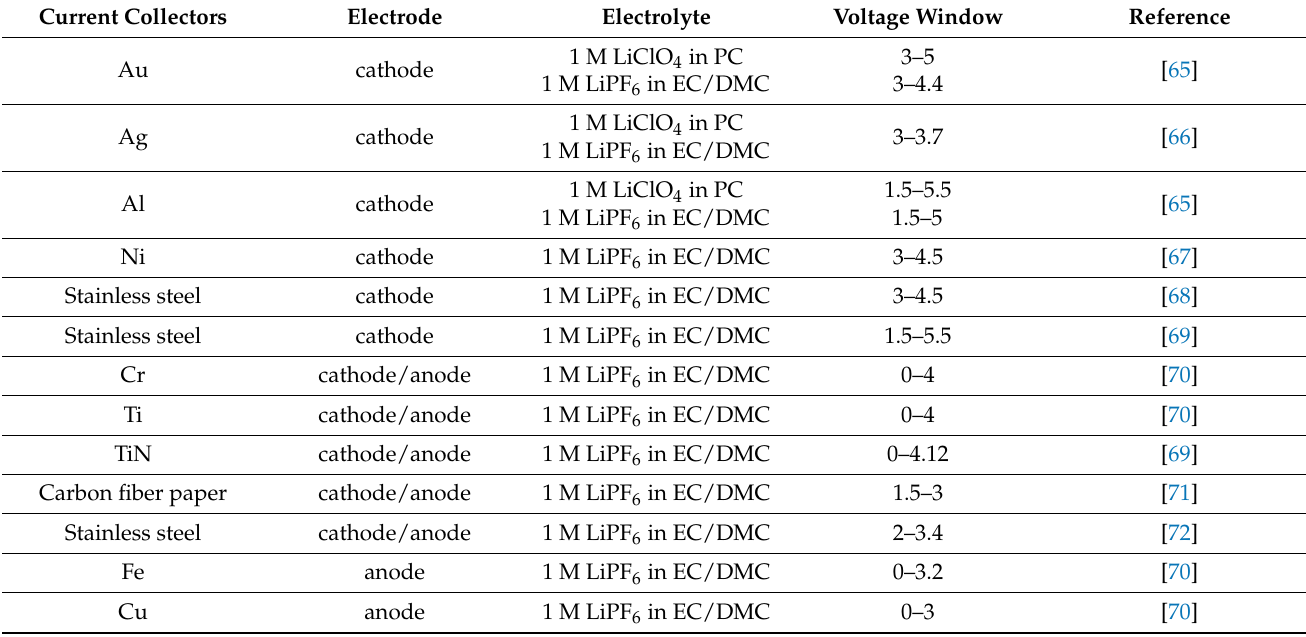
Table 1. Various thin film current collectors for different